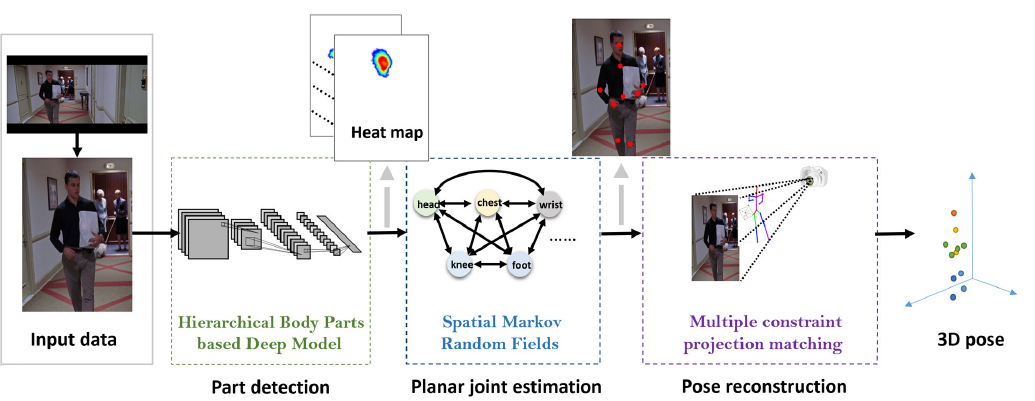
Figure 1. Overview of the framework. With the normalized input, three levels of processing are conducted for part detection, planar pose estimation and spatial pose reconstruction.